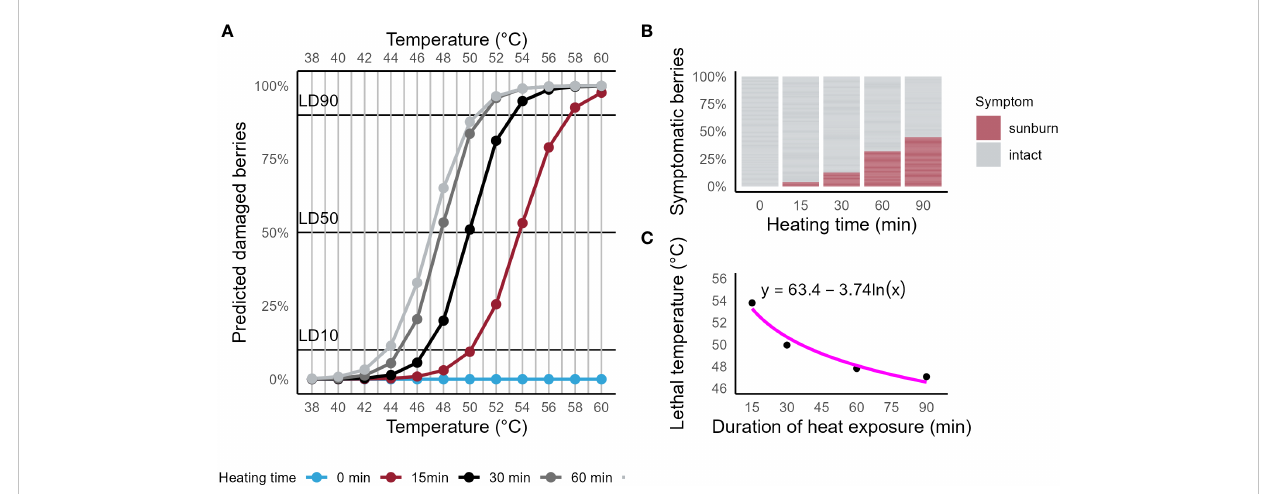
FIGURE 1 (A) Prediction plot for the occurrence of sunburn symptoms on Riesling berries exposed to high temperatures with periodic measurements of berry surface temperature. Binary logistic regression model showed signi fi cance for predictors Surface temperature (Wald = 123.66, p < 0.001) and Time (Wald = 163.62, p < 0.001). (B) Bar plot of the cumulative percentage of berries observed with symptoms of sunburn necrosis for four timepoints (0, 15, 30, 60 and 90 min). (C) Scatter plot of calculated lethal temperatures (LT 50 , probability for symptomatic berries = 50%) for four durations of high heat exposure of grape berries (15, 30, 60 and 90 min). A regression fi t is represented by the solid line (R² = 0.94, F (1,2) = 46.48, p = 0.021).